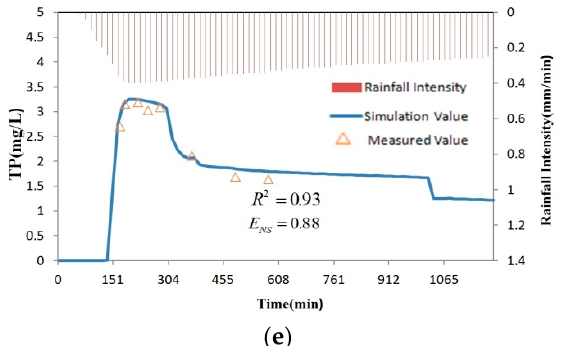
Figure 2. Parameter calibration of ( a ) water quantity and water quality including ( b ) suspended solids (SS), ( c ) chemical oxygen demand (COD), ( d ) total nitrogen (TN), and ( e ) total phosphorus (TP).